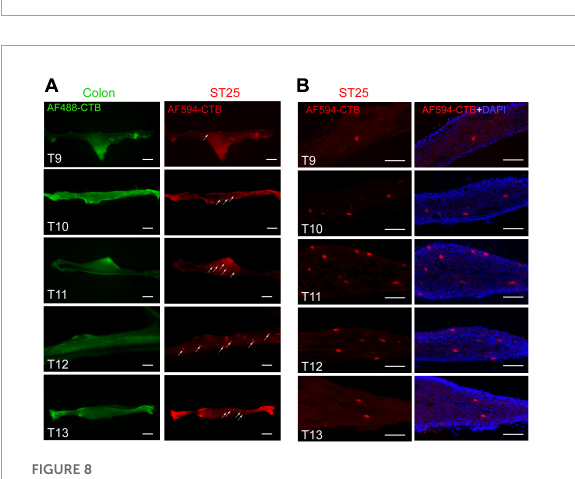
FIGURE8 The positive labeling of the sympathetic chain. (A) Positive labeling of sympathetic chain (not sectioned) under fluorescence microscopy. (B) Representative photomicrographs showing the distribution of AF594-CTB-labeled post-sympathetic neurons in the sympathetic chain (sectioned) at the thoracic segments. Scale bars = 100 µ